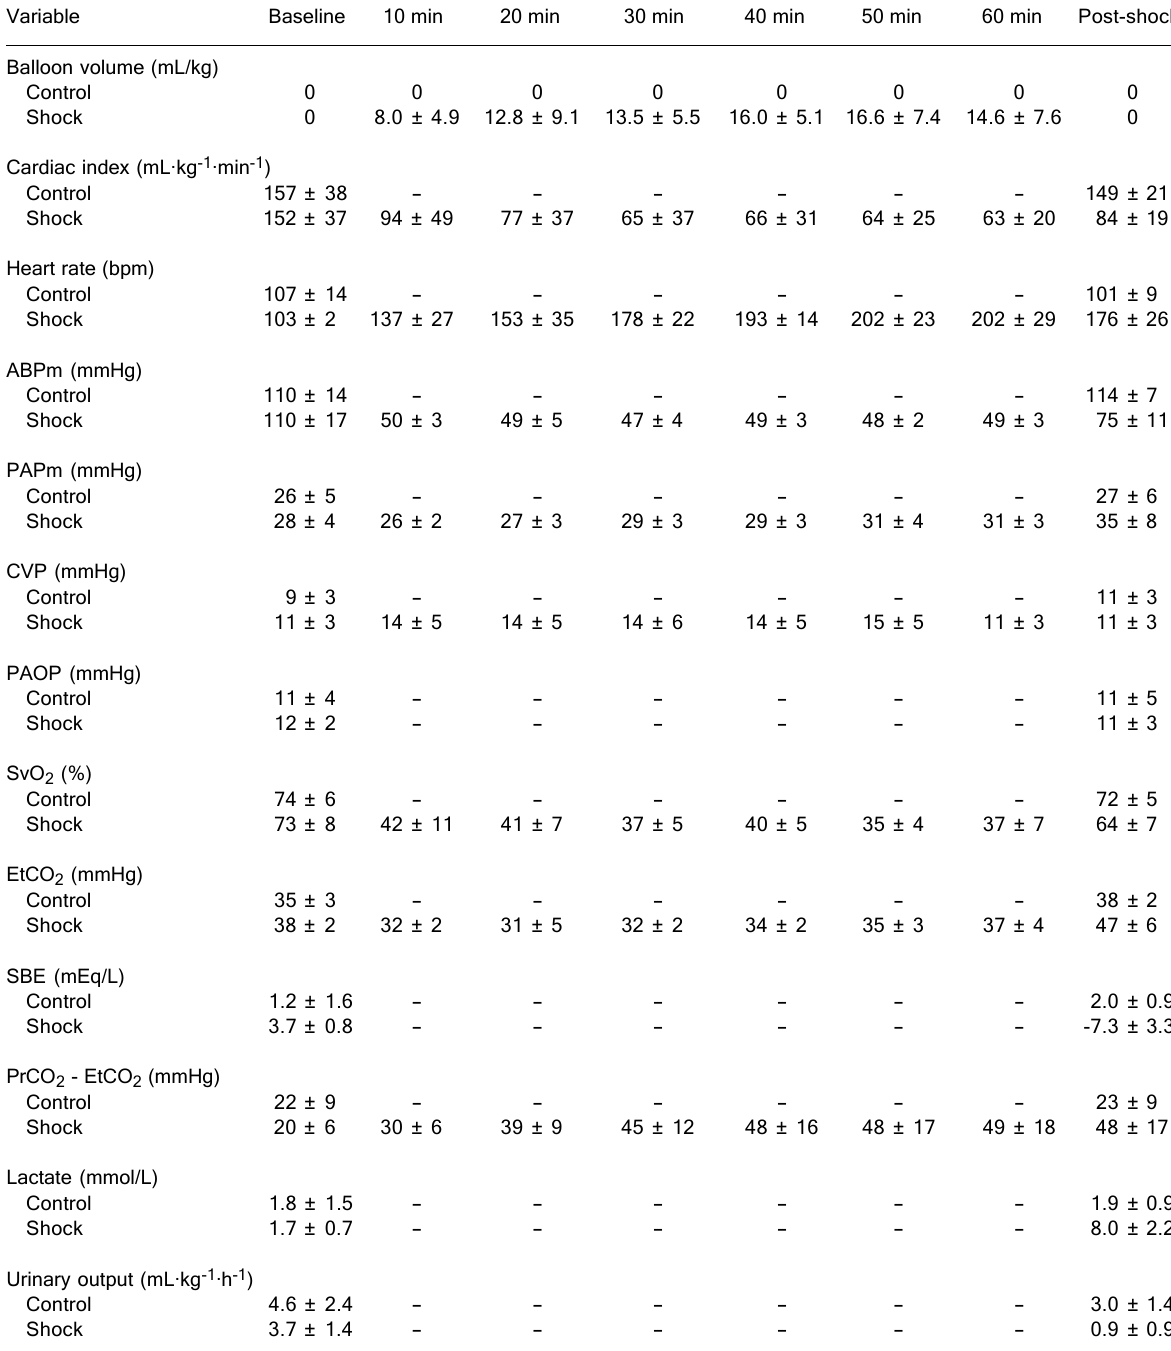
Table 1. Physiological data obtained during the cardiac tamponade shock